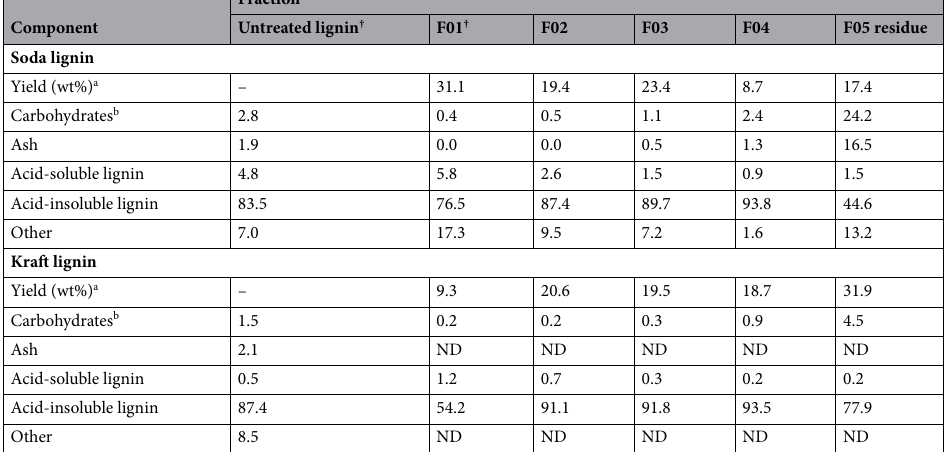
speed of 49,000 rpm (~ 120,000 g) at 20.0 °C. Concentration profiles and movement of the sedimenting bounda- ries within the AUC cells were recorded using the Rayleigh interference optical system registering concentra- tion (in fringe displacement units relative to the meniscus) versus radial position, r 59 . The data were analysed by means of the SEDFIT analytical algorithm 60 , which gives a distribution of sedimentation coefficient, s , and provides an assessment of the polydispersity. The c (s) vs s model was used to analyse the data, thereby generating an apparent distribution of sedimentation coefficients ( s, in Svedberg units S = 10 −13 s) in the form of c (s) versus s , rather than the ls - g (s) model, because of the very low s values and incomplete resolution of the sedimenting boundaries from the air-solution meniscus. Because of the very low concentrations employed, correction for non-ideality (extrapolation to infinite dilution) was not necessary, and the assumption s° 20,w ~ s 20,w is reasonable. A value for the partial specific volume, ῡ , of 0.61 mL g −1 was used 61 . Size exclusion chromatography (SEC).